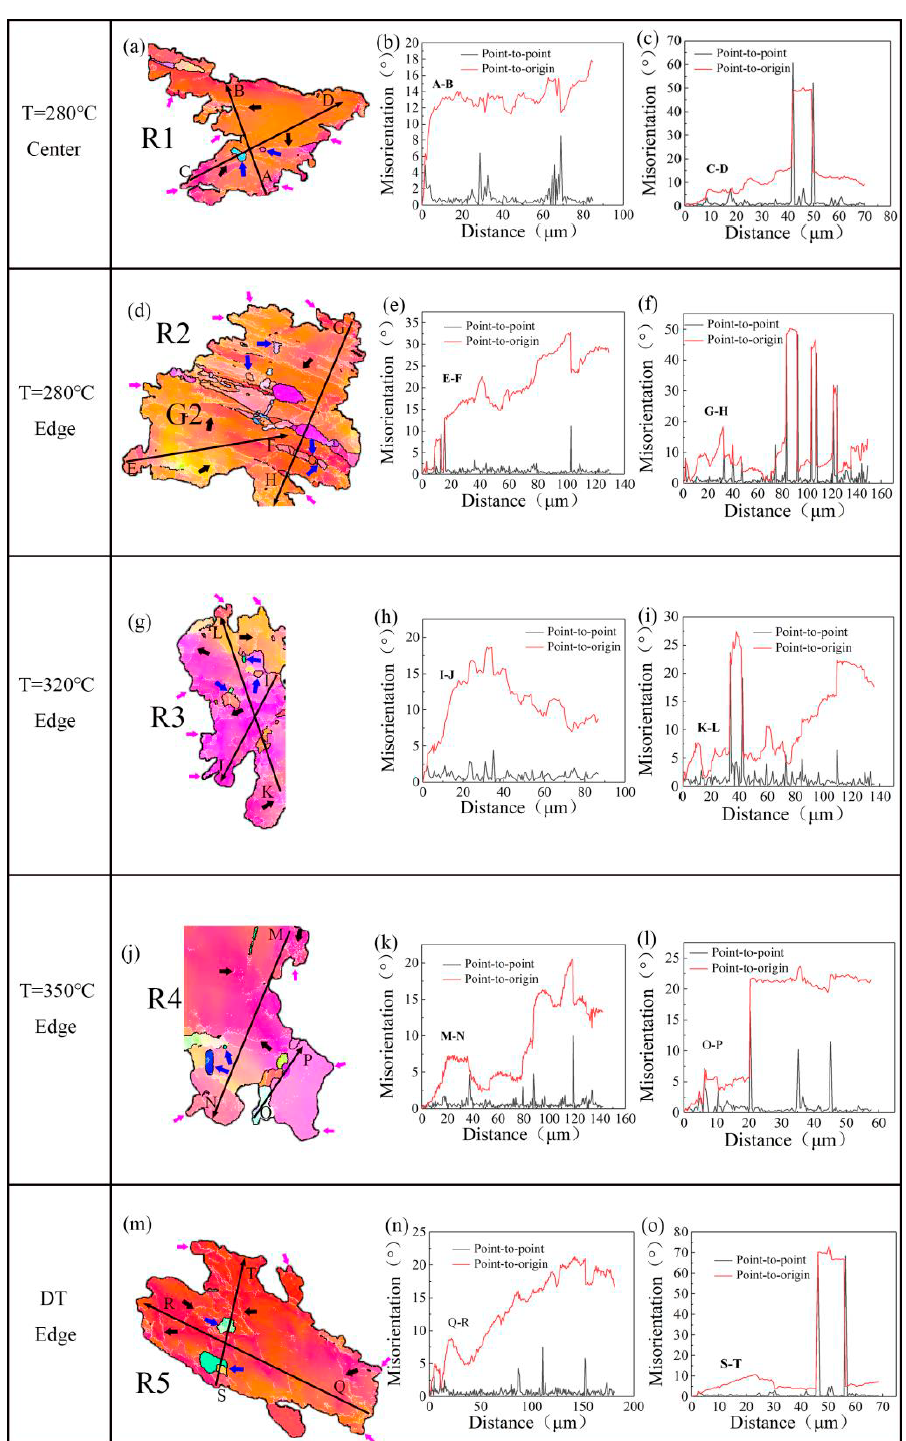
Figure 13. The DRX behavior of original grains in different samples after pass 1 is shown in the first column of the images, and the inverse pole figure maps the line profiles of the misorientation angle along the arrows in the corresponding inverse pole figure maps as shown in the central and right columns: ( a ) Center pass 1 at 280°C; ( b ) Line profiles of arrow AB; ( c ) Line profiles of arrow CD; ( d ) Edge pass 1 at 280°C; ( e ) Line profiles of arrow EF; ( f ) Line profiles of arrow GH; ( g ) Edge pass 1 at 320°C; ( h ) Line profiles of arrow IJ; ( i ) Line profiles of arrow KL; ( j ) Edge pass 1 at 350°C; ( k ) Line profiles of arrow MN; ( l ) Line profiles of arrow OP; ( m ) Edge pass 1 at DT; ( n ) Line profiles of arrow QR; ( o ) Line profiles of arrow ST.